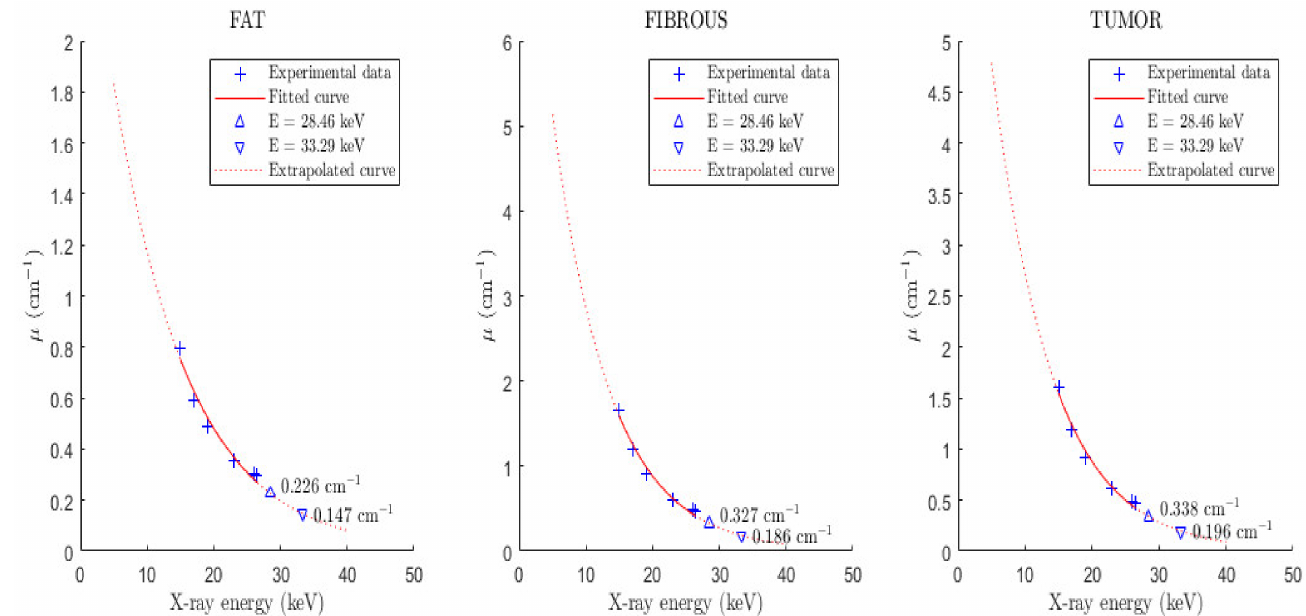
Figure 4. Figure illustrates the exponential fitting for the extraction of tissue (fat, fibrous, tumor) linear attenuation coefficients at X-ray energies 11.20 keV, 12.50 keV, 28.46 keV and 33.29 keV, respectively. The experimental data were taken from Chen et al.